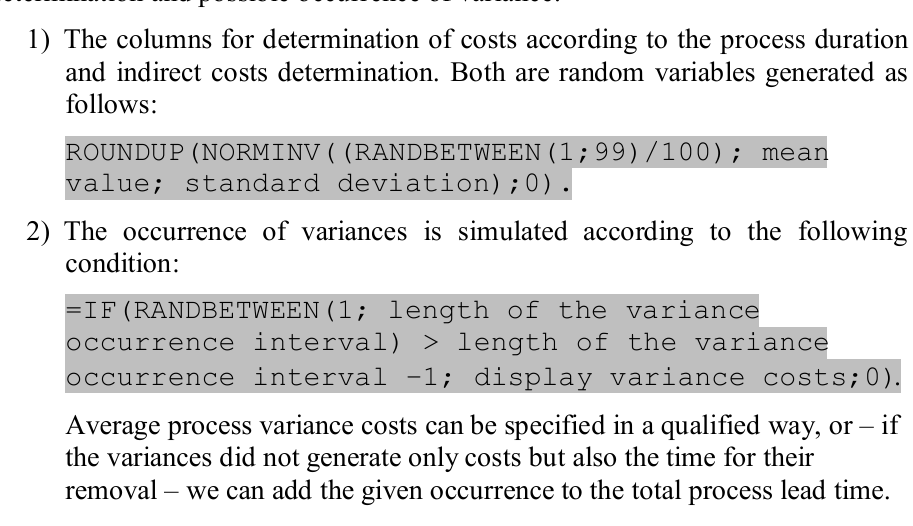
Table 5 – Resource quantification overview Resource Price for Cold storage